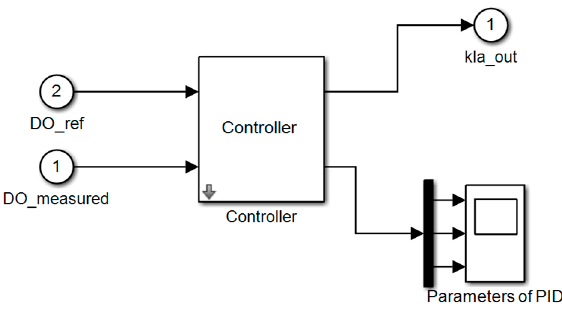
Figure A1. Overview of the DO control module.